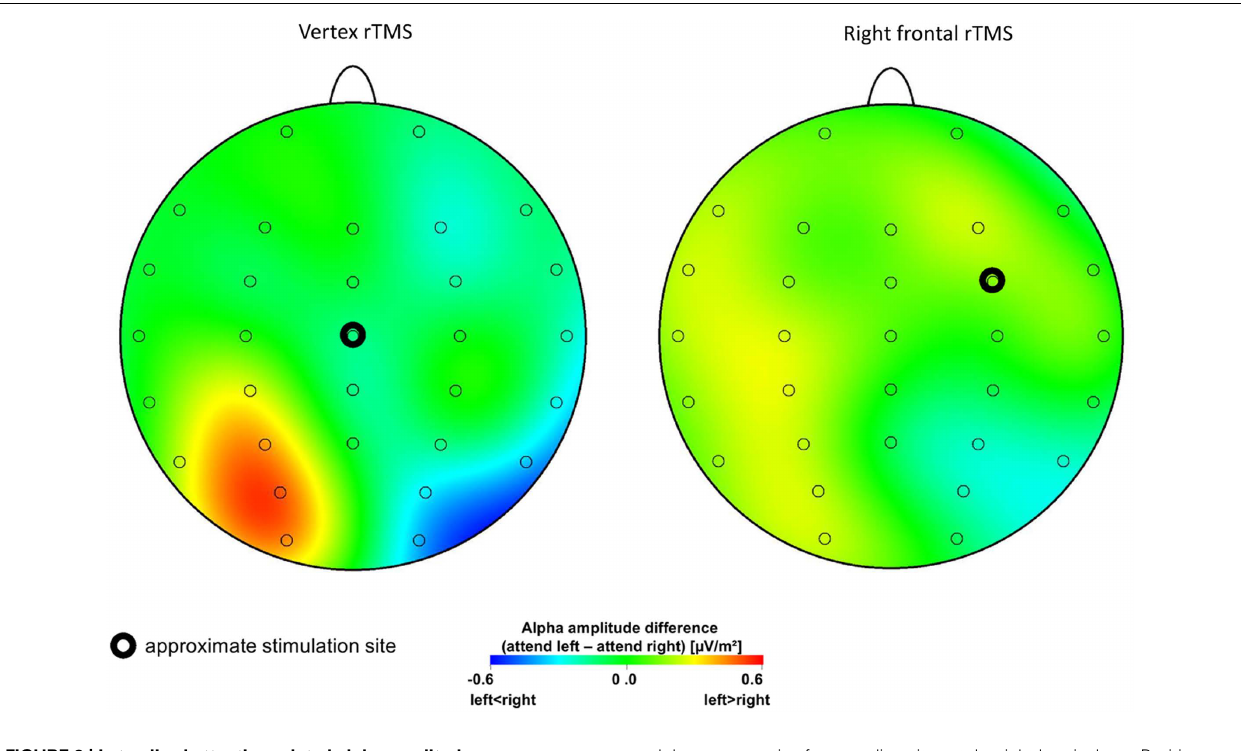
FIGURE 2 | Lateralized attention-related alpha amplitude. Topographical maps display anticipatory upper alpha amplitude difference values between conditions with attention directed to the left minus right visual hemi-field. Since ipsilateral alpha amplitude is increased compared to contralateral activity these difference values (attention left minus attention right) are positive for electrode sites over the left hemisphere,